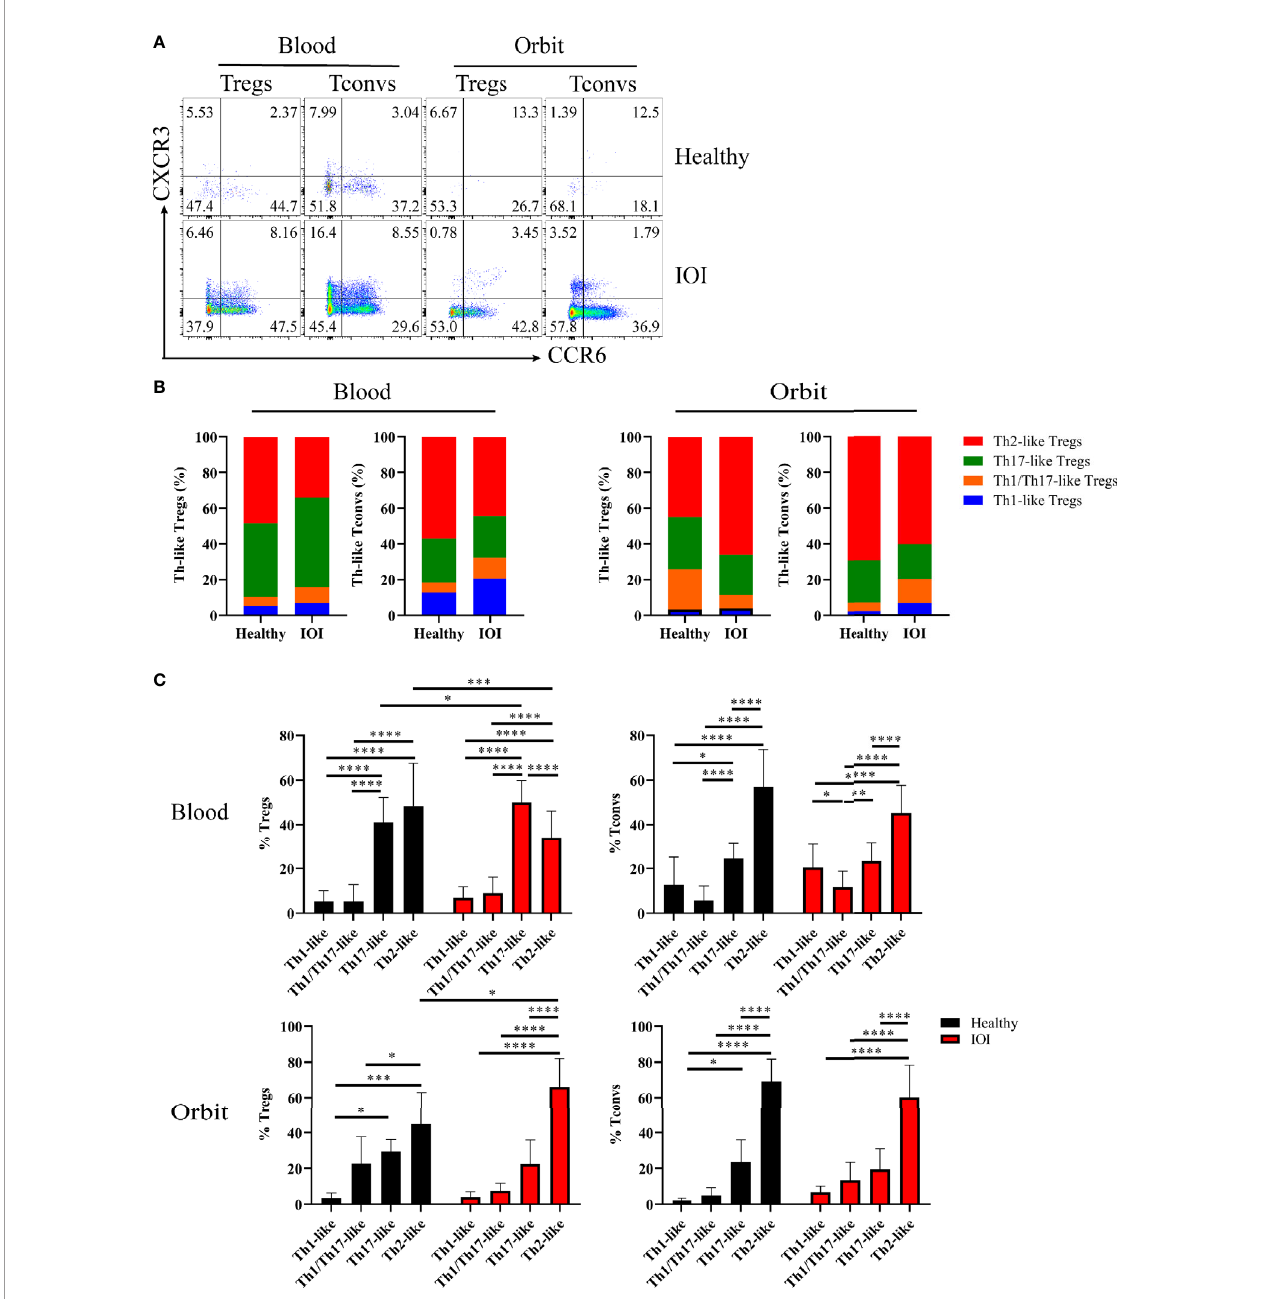
FIGURE 4 | Distribution of Th-like regulatory T cells (Tregs) in healthy subjects and patients with idiopathic orbital in fl ammation (IOI). (A) Representative plots of chemokine receptor CCR6 and CXCR3 expression in CCR4+ Tregs and conventional T cells (Tconvs). (B, C) Percentages of Th-like Tregs in peripheral blood (healthy, n = 15; IOI, n = 21) and orbit (healthy, n = 4; IOI, n = 5). * P < 0.05; ** P < 0.01; *** P < 0.001; **** P <